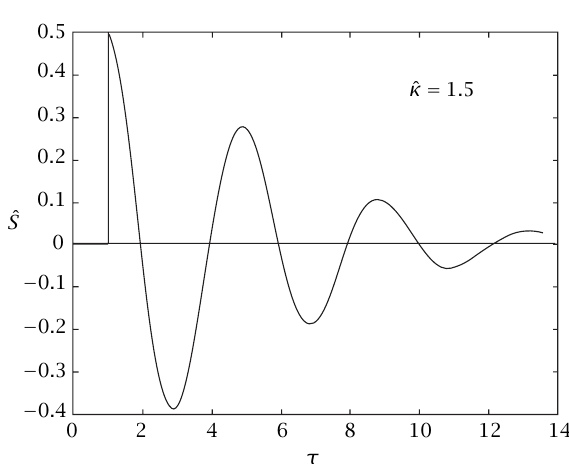
Figure 2.1 . The stress ˆ S as a function of dimensionless time τ ( 0 ≤ τ ≤ 14 ) at the cross-section ξ = 1 and for ˆ κ = 1 . 5 .